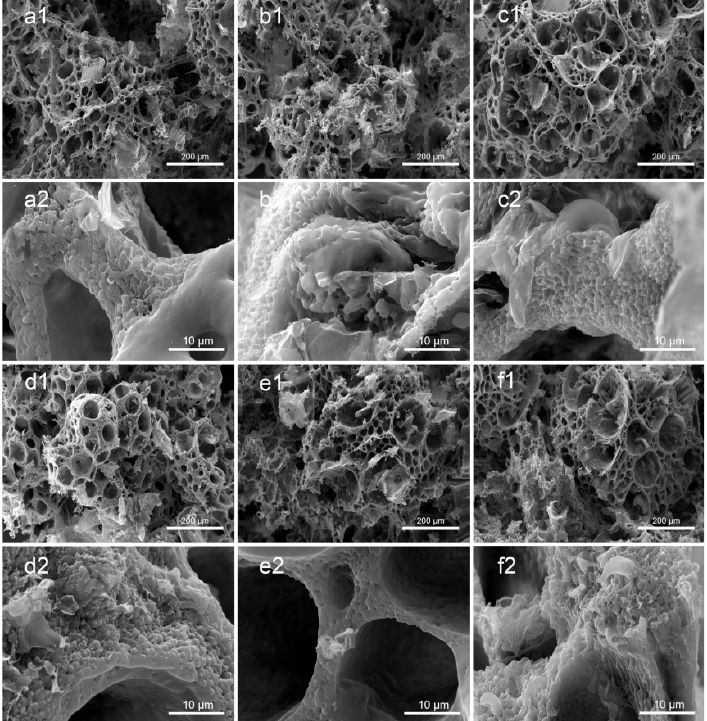
Figure 2. Morphology of the dual drug ‐ loaded biomimetic composite scaffold: ( a1 , a2 ) S0A5; ( b1 , b2 ) S1A5; ( c1 , c2 ) S3A5; ( d1 , d2 ) S5A5; ( e1 , e2 ) S3A10 and ( f1 , f2 ) S3A15.